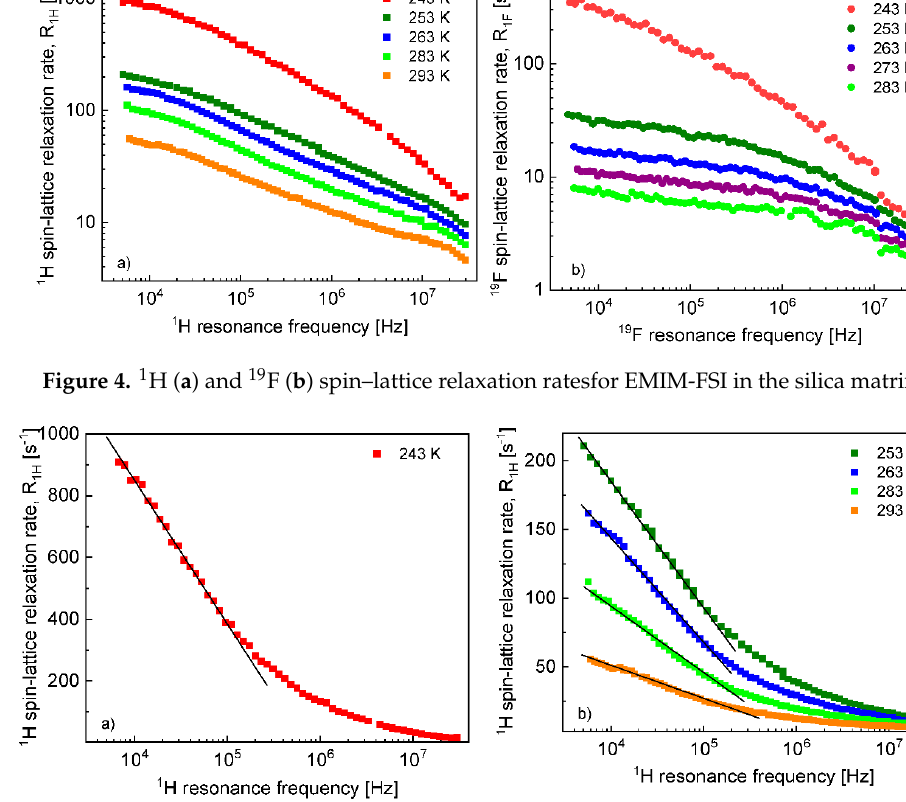
Figure 5. 1 H spin–lattice relaxation rates for EMIM-FSI in the silica matrix at ( a ) 243 K and ( b ) from 253 K to 293 K; lines—linear dependencies characteristic of 2D translation diffusion.